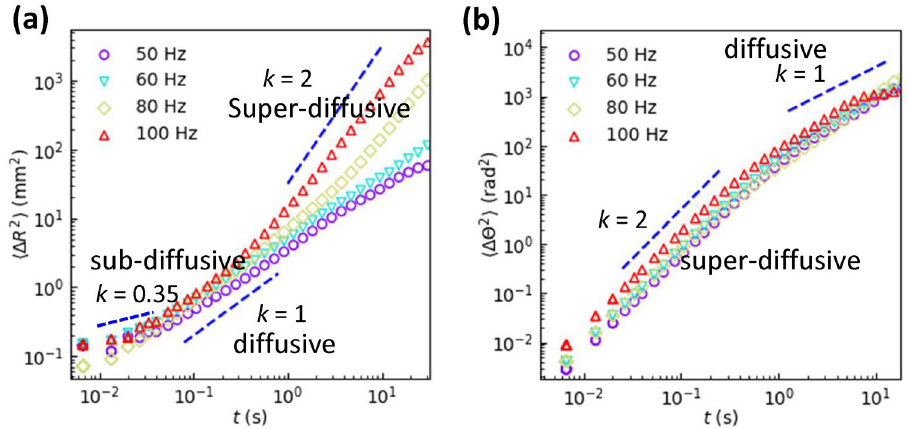
50 Hz, 60 Hz, 0.6 mm and f t k under A = ∝ =